Question: What type of chart is this?
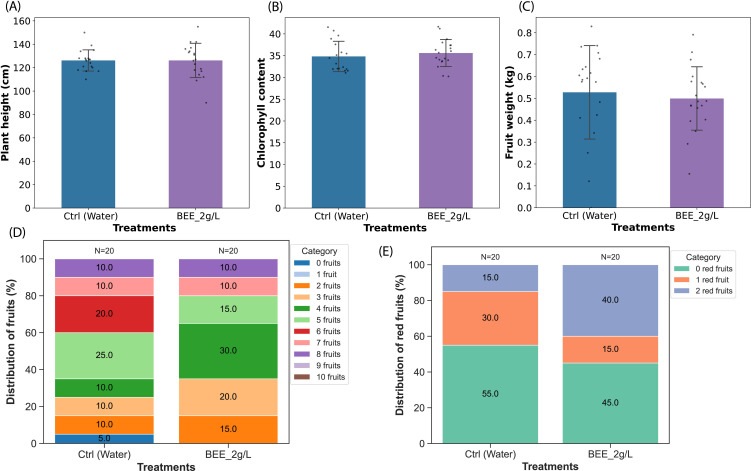
Answer: bar